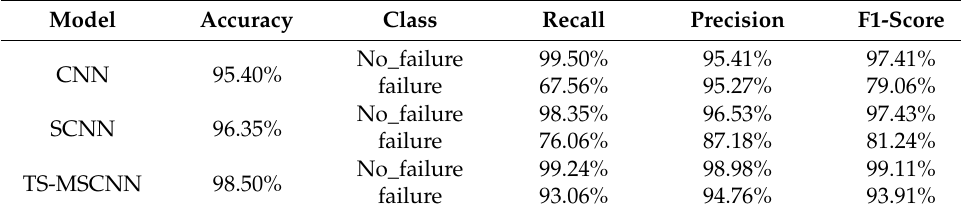
Table 4. The detailed performance of CNN, SCNN, and